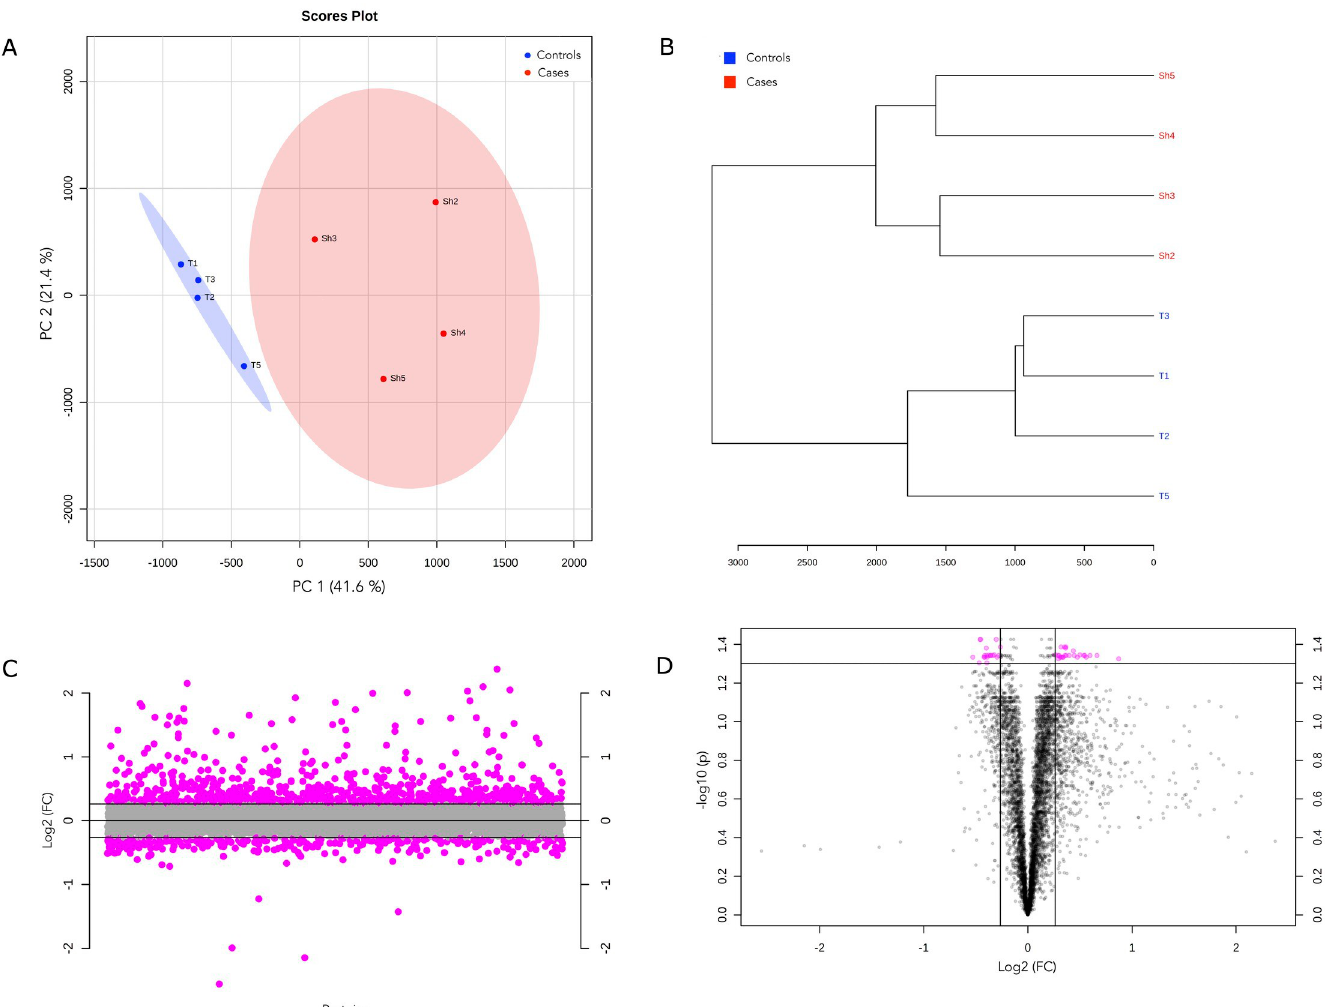
Fig 2. Differential protein expression in the bladder tissue proteome between cases and controls. a) Scores plot from principal component analysis (PCA) across samples, annotated by group. The explained variances are shown in brackets. b) Protein abundance dendrogram. From abundance data, the Euclidean distance was calculated, and samples were clustered based on distances (clustering algorithm–Ward’s linkage). c) Proteins identified by fold change (FC) analysis of case/control ratio with 1.2-FC threshold. Values are on a log scale to show both up-regulated (positive log scale) and down-regulated (negative log scale) proteins symmetrically. Pink symbols represent proteins above the 1.2-FC threshold. d) Volcano plot of differentially expressed proteins (DEPs, n = 45) as measured in bladder tissue. Plot is shown comparing protein abundance in egg-injected bladders relative to tissue extract-injected bladders (i.e., cases/controls). Pink symbols represent proteins above the 1.2-FC (log 2 FC = ± 0.3) threshold and an FDR < 0.05.